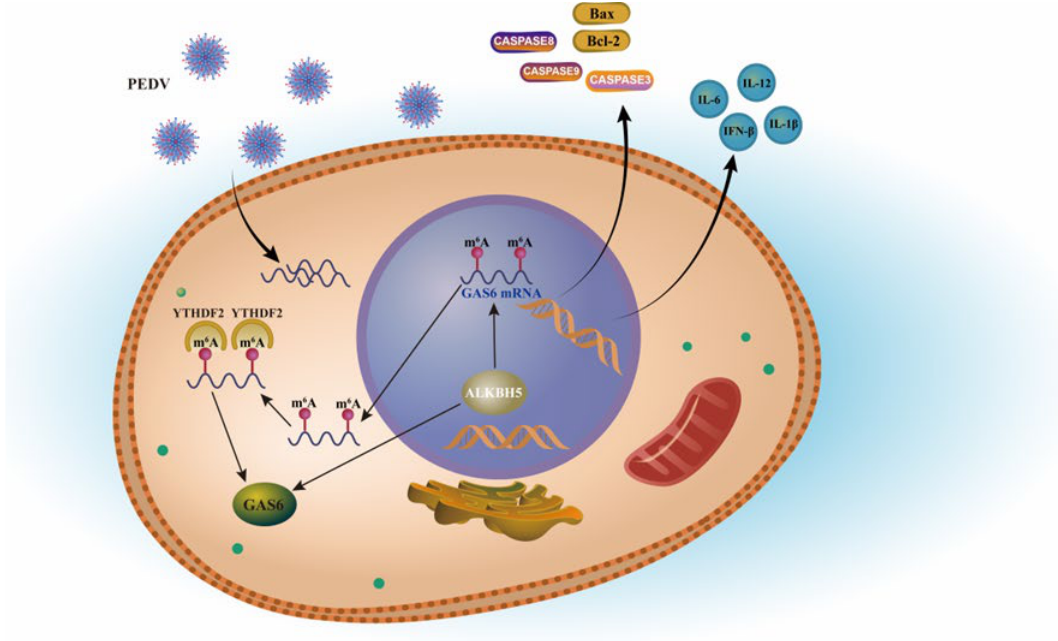
Figure 6. Hypothesis diagram showing that ALKBH5 restrains PEDV infection by influencing the expression of GAS6 .